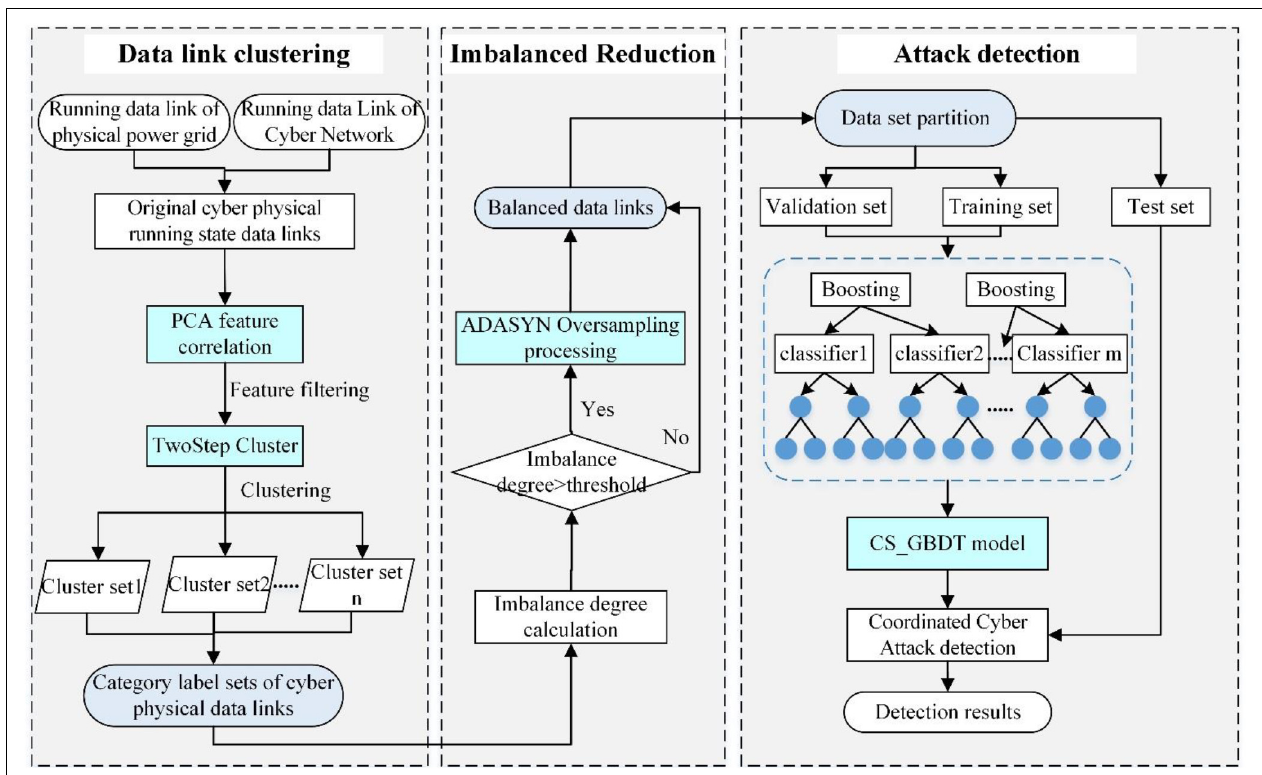
FIGURE 1 | Framework of the coordinated cyber-attack detection model for the Cyber–Physical Power System (CPPS). CS-GBDT, CS gradient boosting decision tree; PCA, principal component analysis.